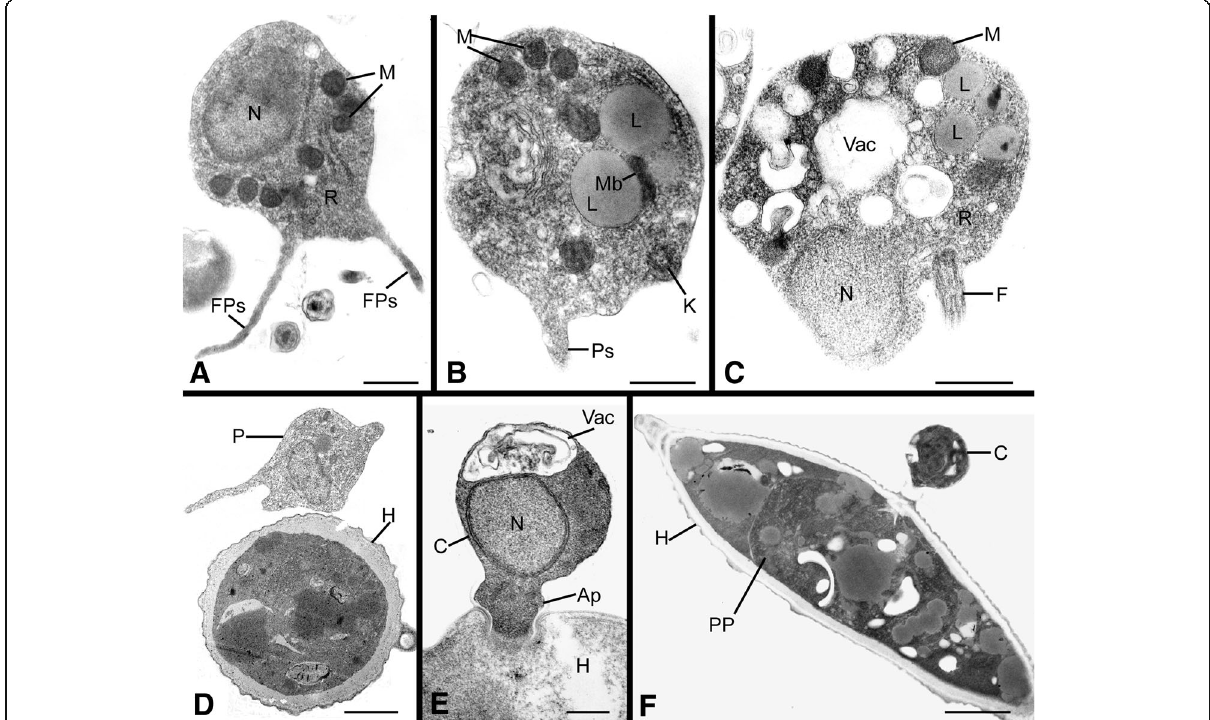
Fig. 2 Transmission electron micrographs of life stages representative of Aphelidiaceae . a Motile zoospore with filose pseudopodia (FPs) and containing a nucleus (N), multiple mitochondria (M), and dispersed ribosomes (R). b Motile zoospore with a pseudopodium (Ps), multiple lipid globules (L) and an adjacent microbody (Mb), and a kinetosome (K). c Motile zoospore with a posterior flagellum (F) and central vacuole (Vac). d Amoeboid zoospore (P) approaching a host cell. e Encysted zoospore (C) containing an anterior vacuole (Vac) and a nucleus, attached to host via an appressorium (Ap). f An infected host cell, with a zoospore cyst attached and the parasitoid plasmodium (PP) inside the host. Figs. A, B, D, E, F =Am. occidentale (FD 01); Fig. C= Aph. desmodesmi strain FD 104. Bars: A – E=5 μ m, F=2 μ